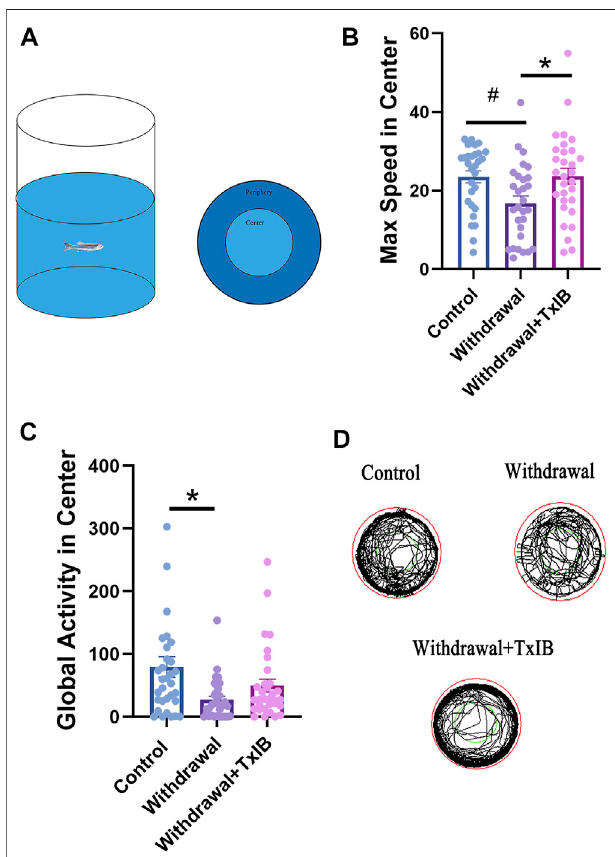
FIGURE 1 | The behavior pro fi le of zebra fi sh in the open fi eld test. Lyophilized TxIB was dissolved in normal saline solution (0.9%) and then injected at 10 μ L per fi sh for a fi nal concentration of 1 mg/kg using the retro- orbital injection method. The control and withdrawal groups were injected with 10 μ L of normal saline solution per fi sh to serve as controls. (A) Thediagramoftheopen fi eldtestwithindividual fi sh,thetank wasdividedinto twoequalvirtualzones,centerandperiphery; (B) Themaxspeedinthecenter zone; (C) The global activity in the center zone; (D) Representative trajectory chartofindividual fi shintheopen fi eldapparatus.Datarepresentedasmean ± SEM (30 zebra fi sh per group). * indicates p < 0.05, # indicates p is between 0.05and0.1(one-wayANOVAfollowedbyTukey ’ smultiplecomparisonstest was